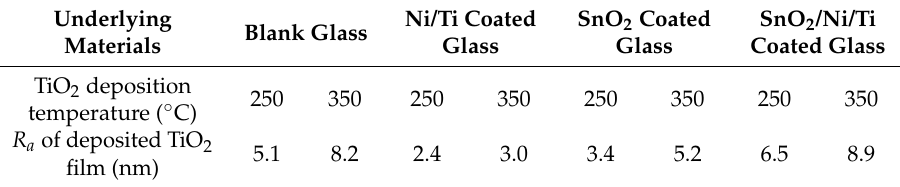
Table 1. Surface roughness of TiO 2 films for the same samples in Figure